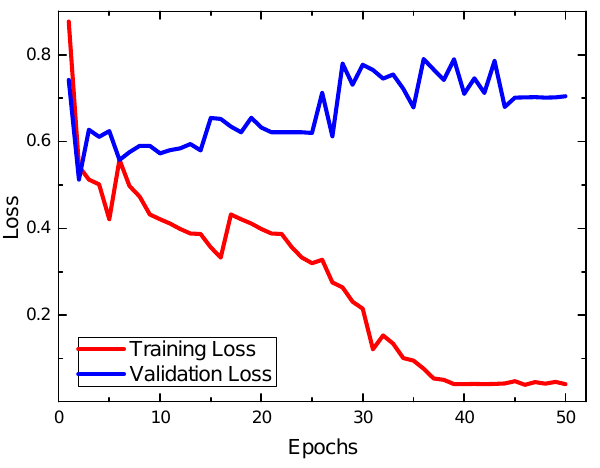
Figure 7. Model training and validation loss curves for the network initialized with pre-trained weights using the CAS-SIAT-Iris dataset.